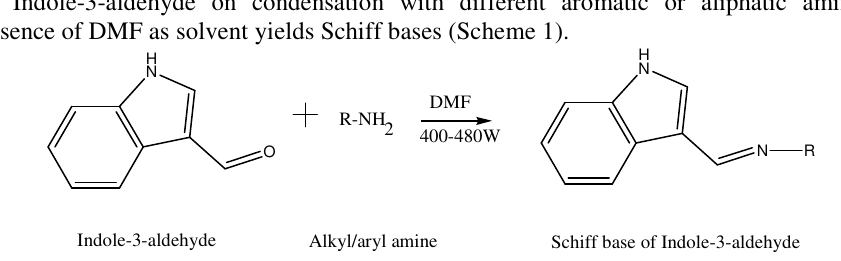
Figure 1. Scheme for the synthesis of Schiff bases